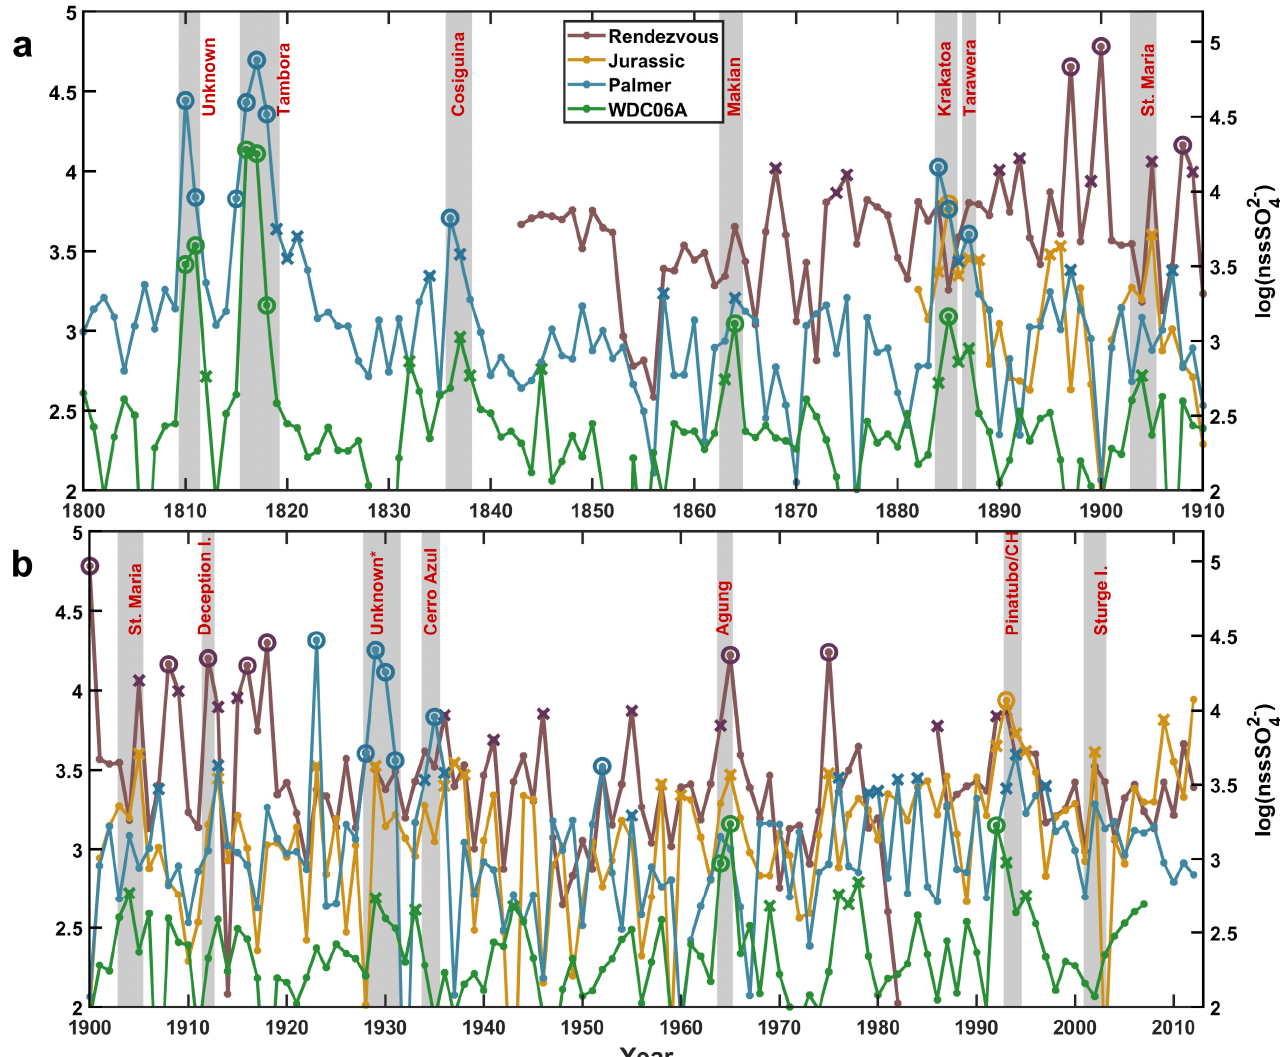
Figure 5. The log-normal of the annually averaged [nssSO 42 − ] records for Palmer (blue line), Rendezvous (purple line), Jurassic (yellow line), and WDC06A (green line). ( a ) shows the 1800–1910 interval and ( b ) the 1900–2011 interval. Grey shading shows volcanic intervals with the corresponding event name in red. Unknown events identified in this study are marked as Unknown*. Years when the [log([nssSO 42 − ]) ≥ background + 2 σ ] are encircled and years when [background + 2 σ > log([nssSO 42 − ]) ≥ background + 1 σ ] are indicated by exes.